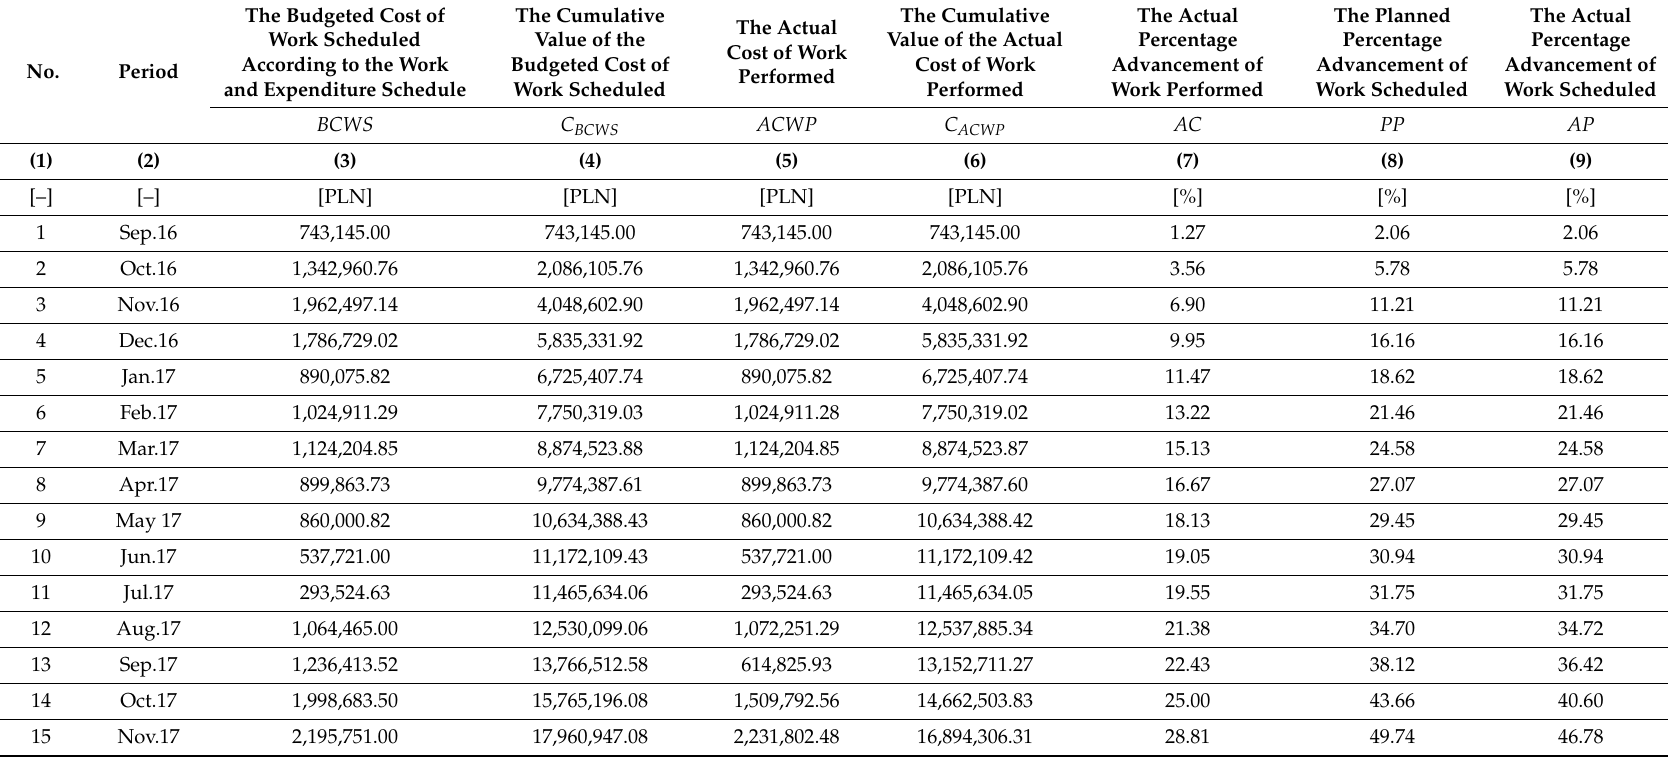
Table 1. Results of measurements and cost analyses of the assessed hotel facility (own